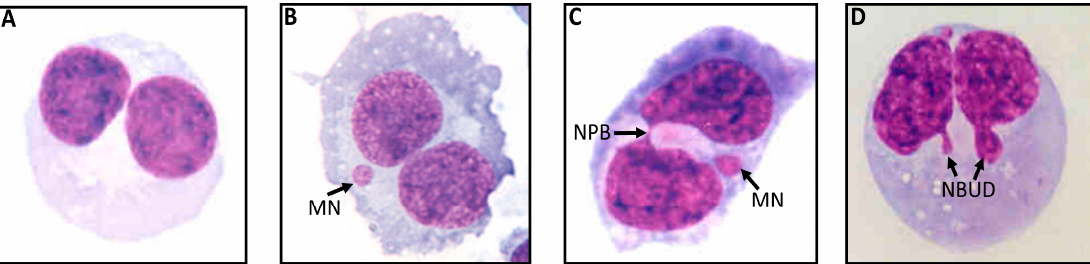
Figure 1. Representative examples of various CBMN cyt assay markers. ( A ) Binucleated (BN) cell without MN, NPB or NBuds, ( B ) BN cell with MN, ( C ) BN cell with NPB and ( D ) BN cell with NBuds.